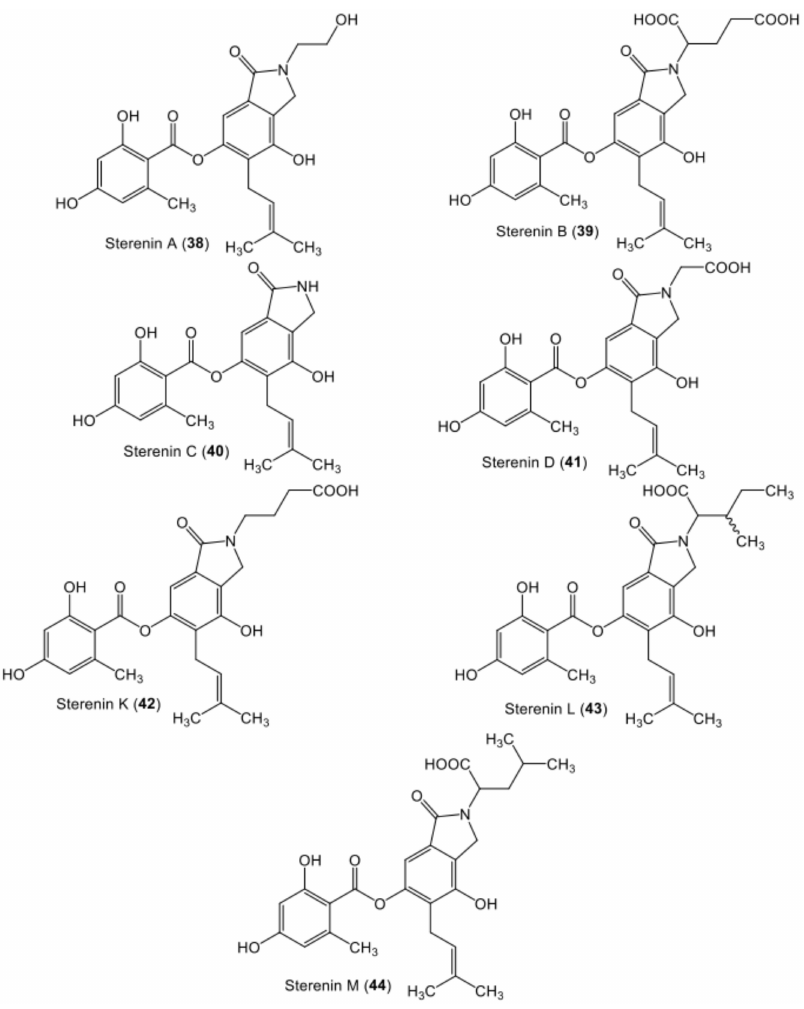
Figure 7. Chemical structures of nitrogen-containing di-depsides 38 – 44 . Phainuphong et al. purified three new depsides, aspergisides A–C ( 3 – 5 ) from As- pergillus unguis , and assessed their antimicrobial potential against MRSA (methicillin- resistant S. aureus ), S. aureus , C. albicans , flucytosine-resistant C. neoformans , and M. gyp- seum [38]. Compound 3 had a weak antibacterial activity toward S. aureus and MRSA, with an MIC (minimal inhibitory concentrations) value of 8 µ g/mL, while 4 and 5 were inactive, with MIC values of 32–200 µ g/mL in the agar diffusion method [38]. Setophoma sp.